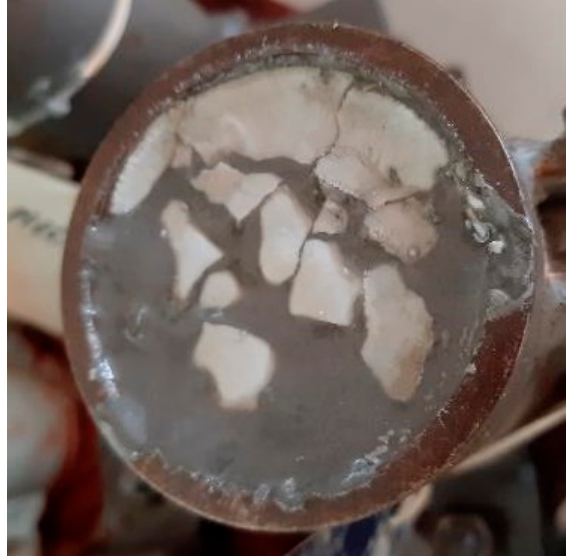
Figure 6. Carbonation observed in the geopolymer created by Method 1 with 24 h at room temper ‐ ature.